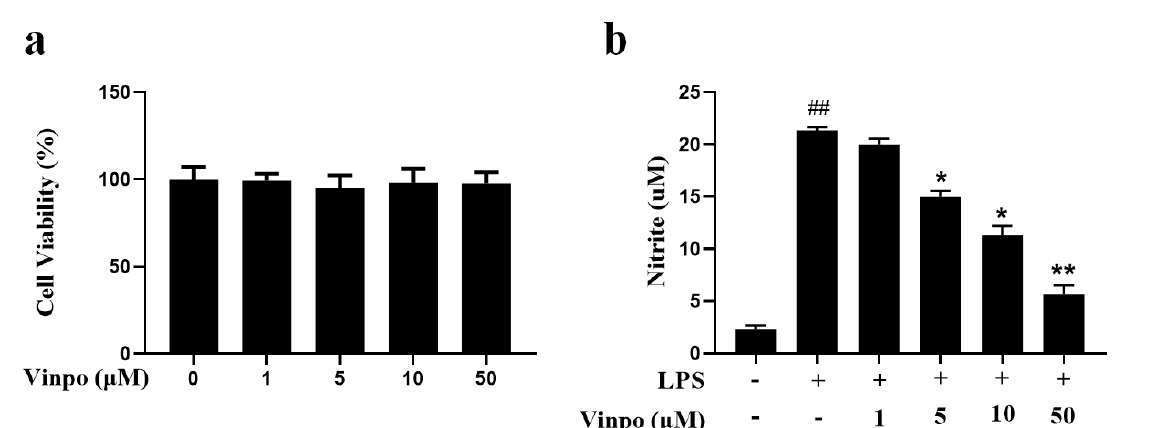
Figure 1. Vinpocetine suppressed LPS-induced NO generation in BV2 microglia. (a) BV2 cells were treated with various concentrations of vinpocetine (0-50uM), cell viability was determined by MTT assay after 24 h. (b) BV2 cells were pretreated with different doses of vinpocetine (0-50 μ M) for 12 h before exposed to LPS (100 ng/mL) for 6 h, Nitrite generation was measured by Griess reaction. Data are representative of three independent experiments. ## P < 0.01, compared with the DMSO treated group; *P < 0.05 and **P < 0.01 compared with the 100 ng/mL LPS-treated group.